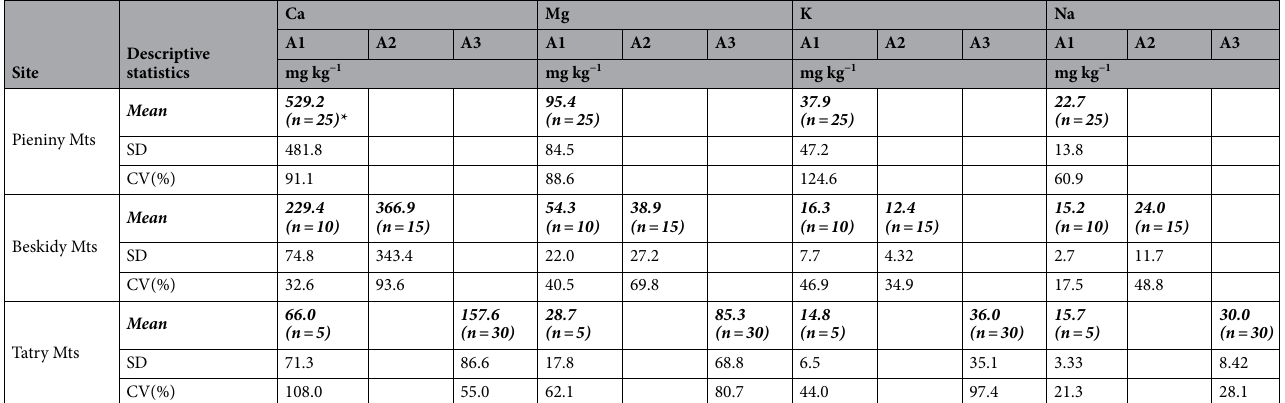
Table 3. Content of active forms of alkaline elements (Ca, Mg, K, Na) in the growth media of A. pinguis cryptic species A genetic lineage A1, A2, A3 at Pieniny, Beskidy and Tatry Mts. *Number of investigated